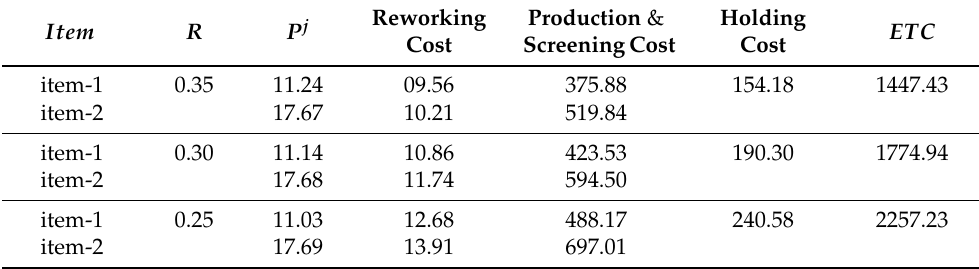
Table 7. Comparison results for different values of R .